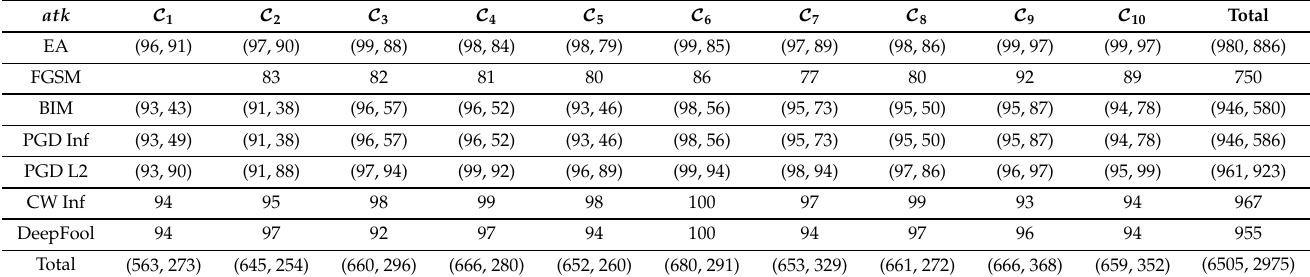
Table 3. For each attack atk , and each C k , the number of successful runs performed on the 100 ancestors are presented, for which at least 35% were terminated successfully. The results are given as a pair ( α , β ) or as a single value α , depending on whether atk is performed for both the untargeted and the targeted scenarios (assessed, respectively, by the values of α , β in the pair), or only the untargeted scenario (assessed by the single value of α ). The statistically relevant successful attacks on each individual CNN are given in the last row with obvious